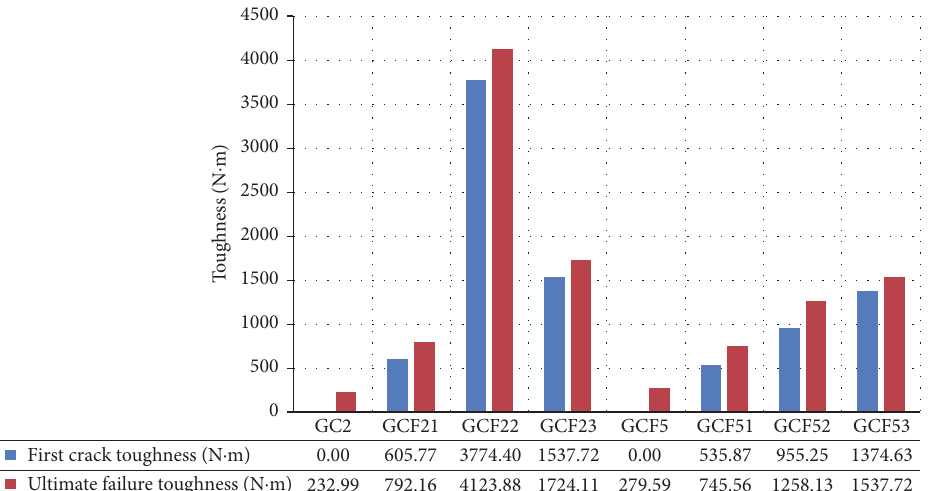
Figure 10: Impact toughness strength test for slag based geopolymer concrete with various percentage of steel fibre (Mix—GC2, GCF21, GCF22, and GCF23).